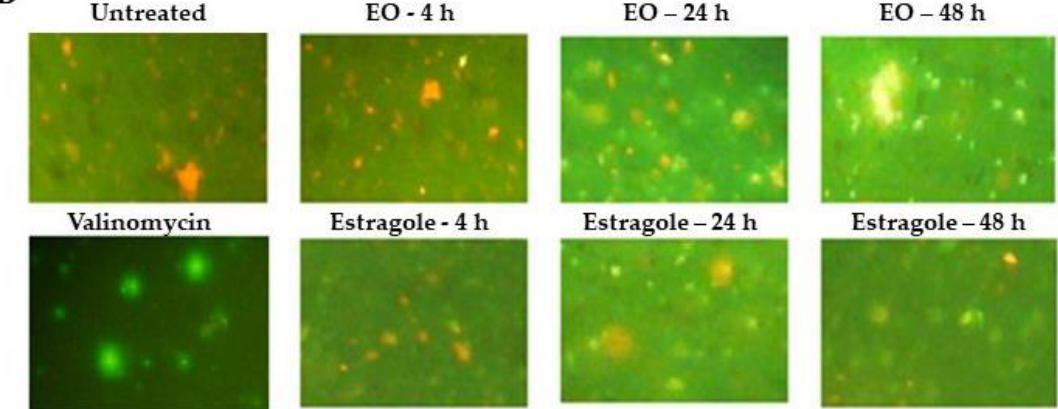
Figure 1. Influence of essential oil from Tagetes lucida Cav. and estragole on mitochondrial function. ( A ): Oxygen consumption (%) of Leishmania tarentolae promastigotes measured with OxoPlates. Untreated parasites in brain heart infusion medium served as a reference at 0 µ g / mL (100% of oxygen consumption), while rotenone (4 µ M) and antimycin A (4 µ M) were included as positive controls. Data are shown as the mean and standard deviation of two replicates. * indicates significant di ff erences ( p < 0.05) with respect to the reference control parasites; ** indicates significant di ff erences ( p < 0.01) with respect to the reference control parasites. ( B ): Mitochondrial membrane potential of L. amazonensis promastigotes was assayed by the JC-1 dye probe (400 × magnification). Cultures of untreated parasites in Schneider’s medium and parasites treated with valinomycin at 5 µ M were included as controls. Green color corresponds to JC-1 monomers, indicating low membrane potential and the orange color indicates JC-1 aggregates, which are formed in mitochondria with high membrane potential because the membrane potential drives JC-1 accumulation. AA: Antimycin A; Rot: Rotenone; EO: Essential oil from T. lucida